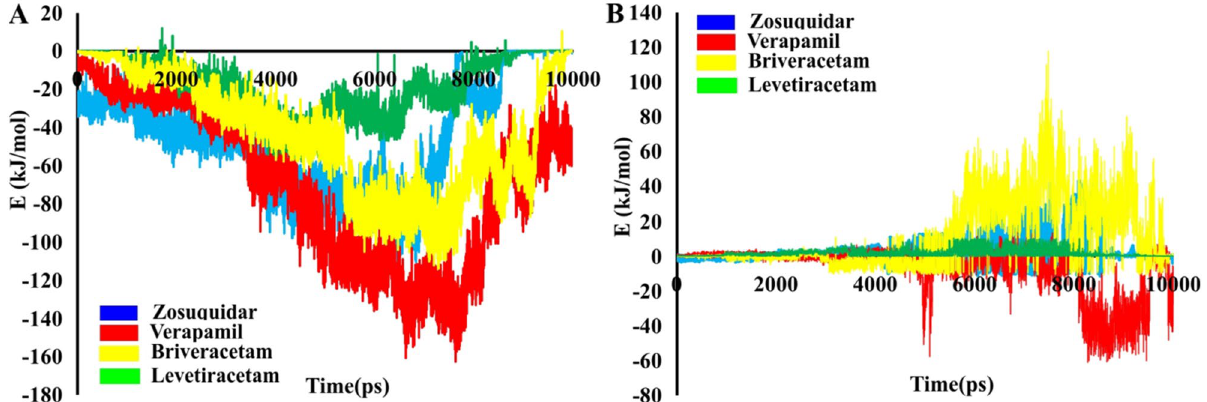
Figure 3. ( A ) van der Waals, and ( B ) electrostatic energies for the interactions of drugs with membrane bilayer Important bindings appear as local and global minima in the energy plots (Fig. 4). The deeper the local minimum a ligand gets stuck in while dynamically interacting with the P-gp transport passageway, the harder it will cross the channel. Thus, deep minima indicate the energy barriers present in the efflux path of the drug. There is an inverse relationship between the ease of drug’s movement in the P-gp channel and the strength of its interaction with lining residues. Our findings show that stronger P-gp-drug interactions in the inner vestibule occur for zosuquidar and verapamil, compared to levetiracetam and brivaracetam. The negative energy values for zosuquidar and verapamil often exceed − 20 kJ/mol, but they are frequently less than − 20 kJ/mol for levetiracetam and even less than − 5 kJ/mol for brivaracetam (though the latter is favored by a strong ionic binding to Q347). These interactions create a larger energy barrier against the passage of the inhibitors through the P-gp channel, while the ASM, levetiracetam, experiences a facile passage along its specific lining in the channel. Potential of mean force from umbrella sampling. To gain a deeper understanding of the dynamic drug-residue interactions along the hP-gp channel, the energy fluctuations relevant to drugs’ transmembrane export during SMD were calculated through the umbrella sampling technique (Fig. 5). The computed potential of mean force (PMF) of drugs through the channel is presented in Fig. 5P, and structurally analyzed in the asso- ciated panels for zosuquidar (Fig. 5Q), verapamil (Fig. 5R), brivaracetam (Fig. 5S), and levetiracetam (Fig. 5T). According to Fig. 5Q(a–d), when zosuquidar moves along the P-gp channel, various hydrophobic interactions and a halogen bond occur between the drug and the lining residues. As a result, the PMF diagram increases steadily with a sharp slope (0.3–3.66 nm of RC; Fig. 5P), then achieves to a plateau at 3.66 nm (Fig. 5P), mean- ing that the compound is completely extruded from the channel. A maximum energy barrier of about 210 kJ/ mol is encountered along the drug’s passage through the inner vestibule of the exporter. At the beginning of the transport process, the PMF diagram of verapamil reduces from 0 to − 12.27 kJ/mol, then the molecule is trapped into its main minimum at RC ≈ 0.25 nm (Fig. 5P,R a). To break this barrier, the drug must ascend to a ≈ 92.12 kJ/ mol of energy level (Fig. 5P,R a–b). At this point, the system first breaks up the hydrophobic interactions between verapamil and the involving lining residues (L65, L126, A129, I299, F303, L339, A342 and F343) (Fig. 5R a–b); thus, PMF value increases relatively sharply until RC of 1.67 nm. Then, the trend becomes smooth (Fig. 5P,R c–d). At the RC of 3.62 nm, the PMF of verapamil reaches a plateau, meaning that the drug is entirely detached from the P-gp protein (Fig. 5P). In the diagram for brivaracetam, two different phases can be seen during the transport process (Fig. 5P). A rapid increase phase from 0.1 to 0.84 nm (Fig. 5P,S a ), and a steady slower increase phase from 0.84 to 2.7 nm (Fig. 5P,S b–d). In the rapid increase phase of brivaracetam release, the hydrophobic interactions between the drug and some residues (V133, W136, and I190) are broken (Fig. 5S a); as a result, the value of the PMF increases rapidly (Fig. 5P). The next phase represents the breakage of bonds between the residues E74, V133, Q132, G191, Q132, Q195, Q347 and P350 of the P-gp channel, and brivaracetam during the umbrella sampling simulation time (Fig. 5P and Fig. 5S b–d). Thus, the PMF value gradually increases between points 0.84 and 2.7 nm (Fig. 5P). The PMF diagram of brivaracetam reached plateaus, suggesting the entirely release of the drug from the P-gp transporter protein (Fig. 5P). It can be seen from the PMF diagram of levetiracetam that the energy is gradually increased from −3.13 to the barrier of 12.12 kJ/mol (Fig. 5P,T a–b), after which it falls into its global minimum (Fig. 5P,T b; RC ≈ 0.69 nm). Obviously, there are hydrophobic and electrostatic interactions between levetiracetam and lining residues in this area (Fig. 5T b). Therefore, the inner vestibule of the P-gp channel has the highest potency to capture lev- etiracetam; hence, we suggest that this area is the binding site of levetiracetam in the hP-gp channel (Fig. 5T b). According to the PMF diagram, levetiracetam encounters an energy barrier of about 83.2 kJ/mol while crossing the channel (Fig. 5P, RC ≈ 2 nm, and 5T b–d). Therefore, at the beginning of the transport process, the PMF trend of levetiracetam rises rapidly to pass the energy barrier (Fig. 5P, T b–d, RC ≈ 0.69–2 nm). After the drug passes through this area (RC ≈ 2 nm), the diagram gradually reaches plateaus, meaning that the drug has moved away and extruded from the channel (Fig. 5P).